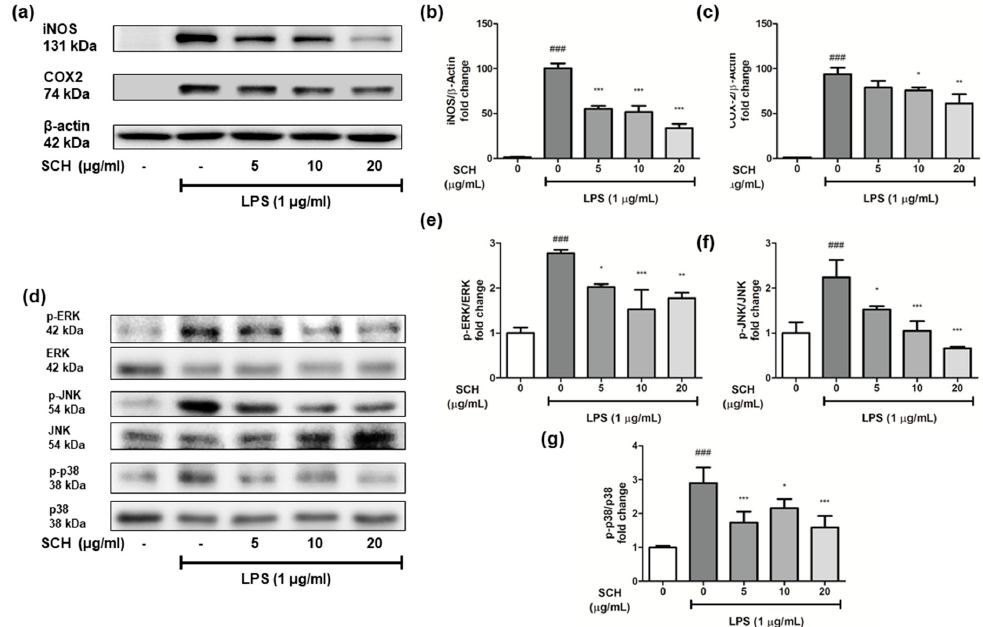
Figure 6. Effects of SCH on iNOS, COX-2, and mitogen-activated protein kinase (MAPK) activities as determined by western blot in Raw 264.7 cells. ( a ) Representative immunoblot images of iNOS and COX-2. ( b , c ) Band intensities of immunoblots of iNOS and COX2 were normalized versus intensities in non-treated cells. ( d ) Representative immunoblot images of ERK, JNK, and p38 and their phosphorylated forms. ( e – g ) Band intensities of immunoblots of phosphorylated ERK, JNK, and p38 normalized versus their intensities in non-treated cells. Results are presented as means ± SDs. # p < 0.05, ## p < 0.01 vs. non-treated control cells. * p < 0.05, ** p < 0.01 vs. LPS-treated cells.